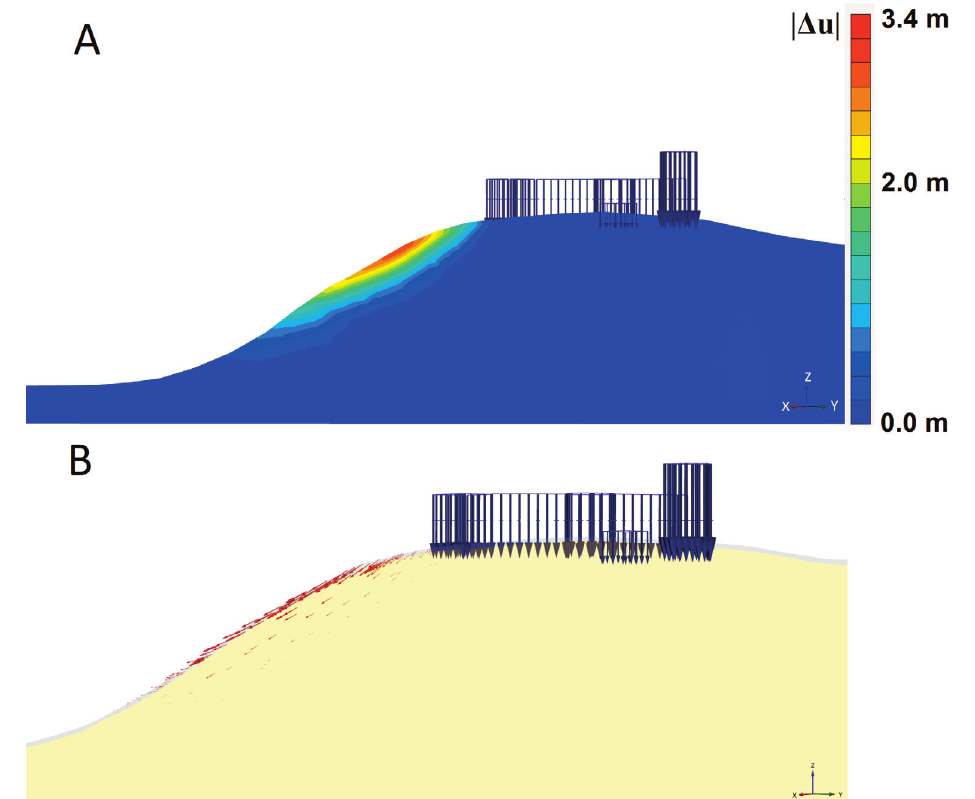
Fig. 8. The modelled sliding surface in the most landslide-susceptible section in colluvium visualized through shadings of the total displacement increments (| Δ u|) ( A ) and displacement vectors ( B